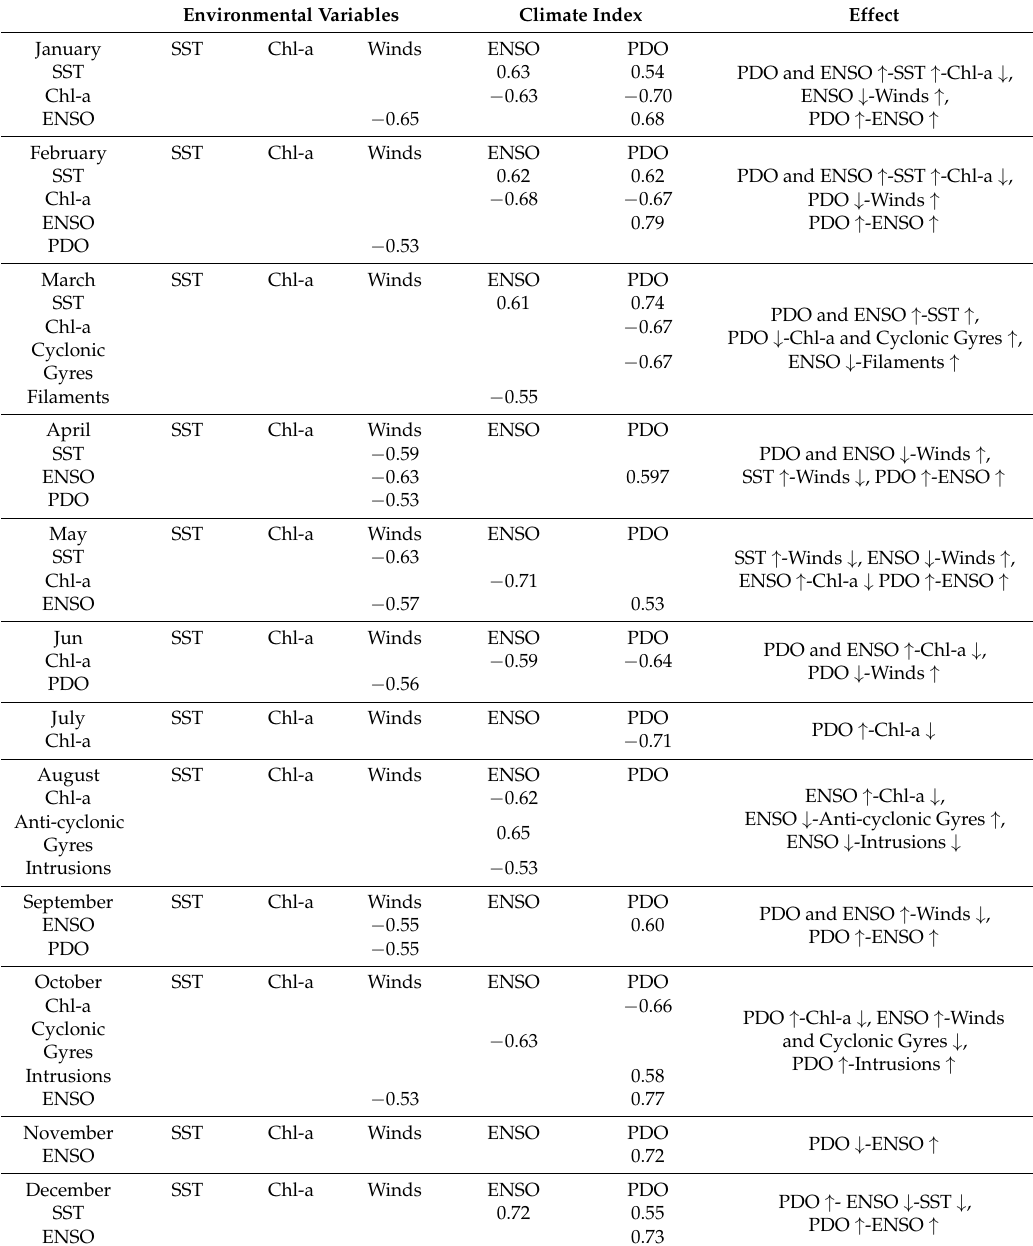
Table 5. Spearman’s (R 2 ) correlation by month among temperature, chlorophyll a, mesoscale phenomena, winds and climate indexes observed in the central and southern coastal region of Sonora and adjacent oceanic zone in the Gulf of California, Mexico, from